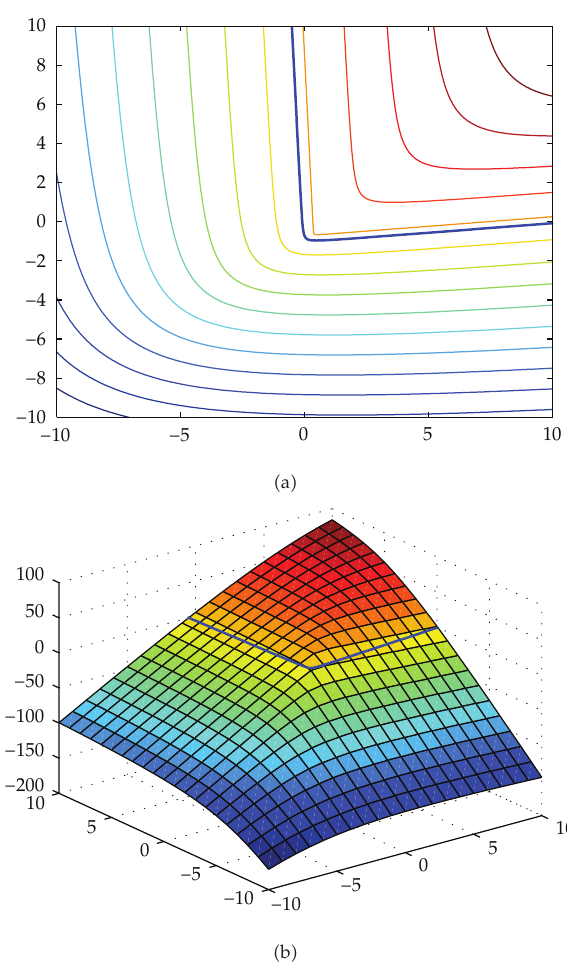
Figure 2: The contours and graph of f (cid:2) x (cid:3) for cone (cid:2) 1 (cid:3) of Example